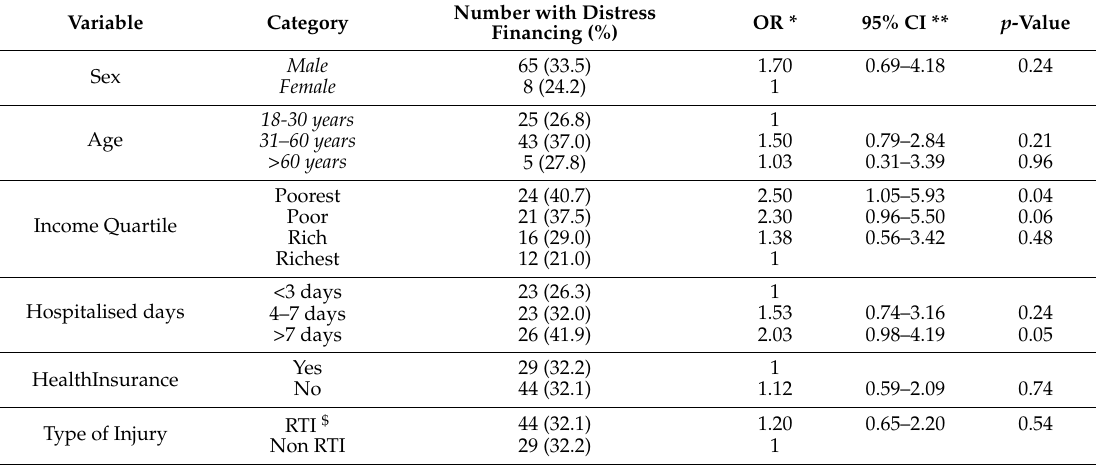
Table 4. Prevalence of distress financing during hospitalisation and its risk